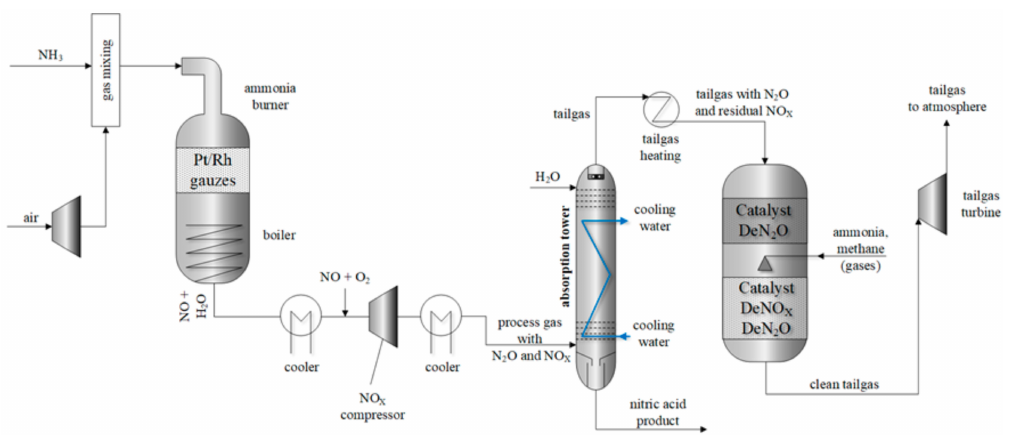
Figure 1. Nitric acid production and tail gas